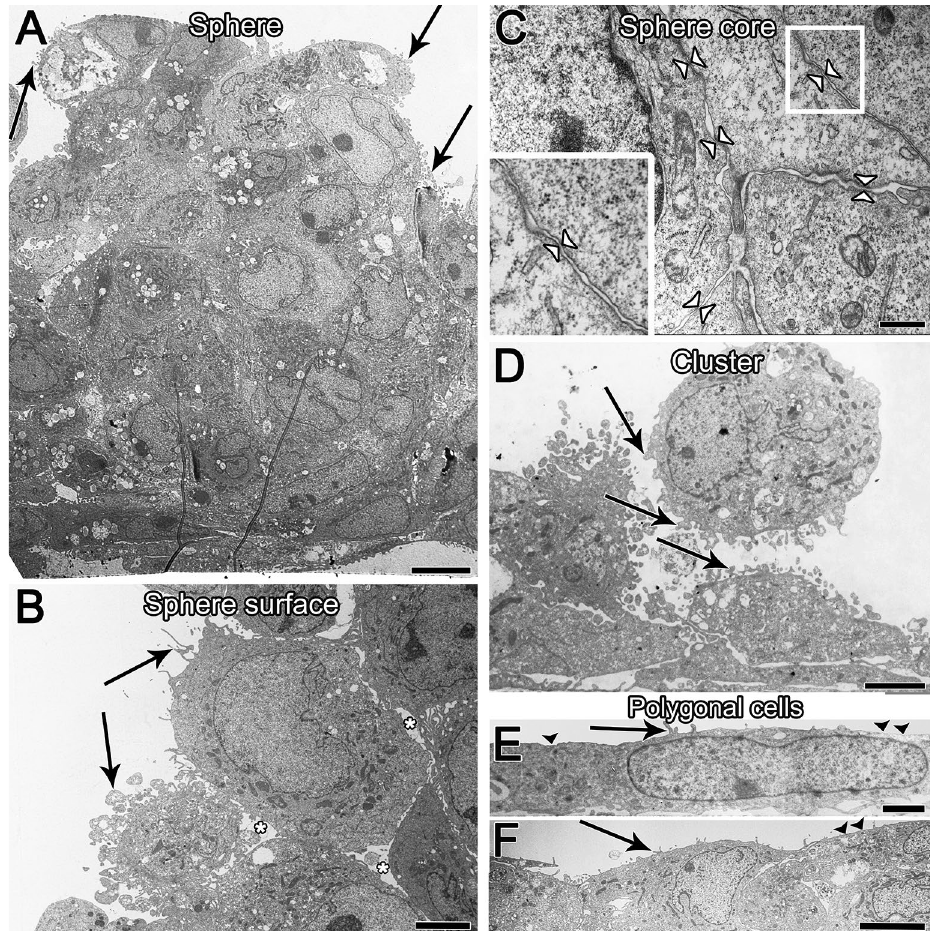
Figure 5. The ultrastructure of spheres, clusters, and polygonal cells observed in all FLO-1 models in vitro regardless of culture media. FLO-1 cells forming spheres are round or oval ( A ). The surface of cells located on the periphery of the spheres is shaped in round protrusions or microvilli or both (arrows, A , B ) and cells are often loosely attached ( B , asterisks indicate large intercellular spaces). Conversely, cells located inside the spheres have a relatively smooth surface and are more tightly connected ( C , arrowheads indicate cell contacts). The cell surface of FLO-1 cells forming clusters is usually shaped in protrusions and microvilli (arrows, D ). Cells are loosely attached ( D ). Cells forming a monolayer or bilayer are usually elongated and flattened, often with elongated ellipsoidal nuclei ( E ,F). Their surface is relatively smooth (arrowheads, E , F ), or shaped in microvilli (arrows, E , F ). Large inset framed with white lines in image C is 100% enlarged image of corresponding small white framed inset. Scale bars, 10 µm ( A ), 6 µm ( B ), 4 µm ( D ), 2 µm ( E ), 0.6 µm ( C , F